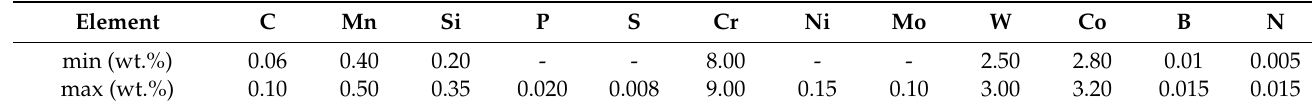
Table 2. Chemical composition of of MarBN